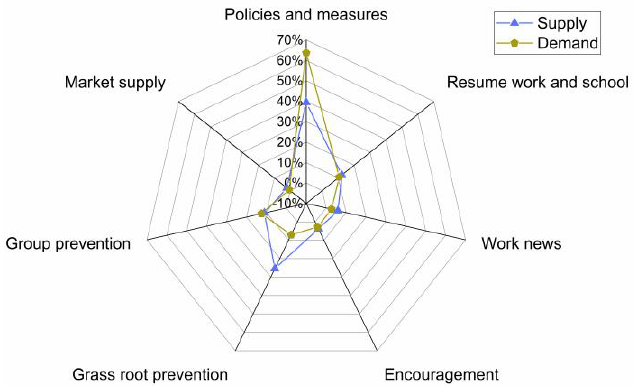
Figure 12. The degree of information matching between supply and demand in the control stage.